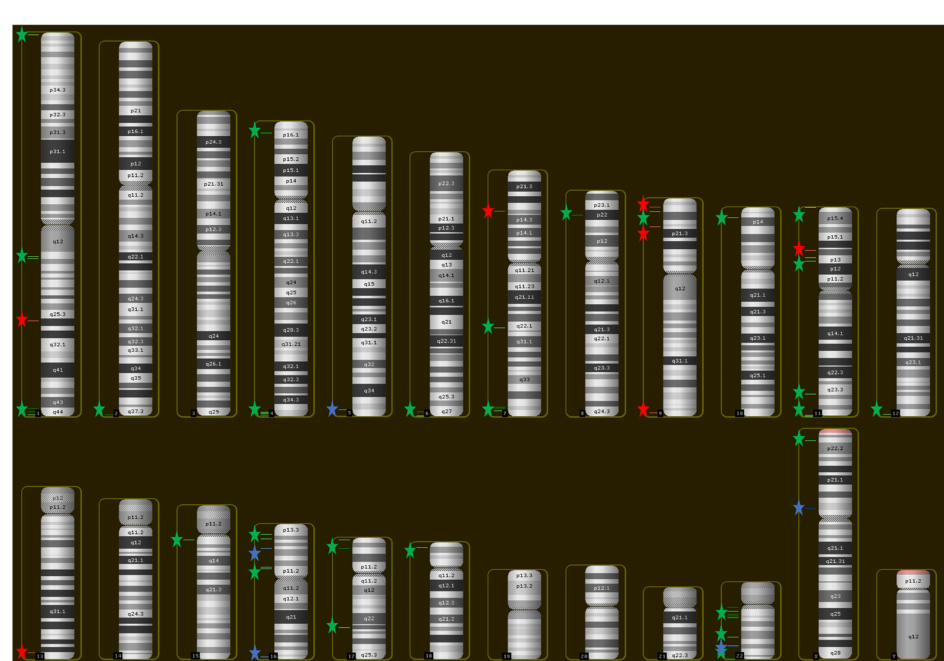
Figure 2. SRO Distribution across the Genome. Chromosomal locations for each SRO were used to construct a BED (Browser Extensible Data) file which was imported into Chromosome Analysis Suite (ChAS; Affymetrix, Inc./Thermo Fisher Scientific, Santa Clara, CA, USA) as a track. Green stars indicate SROs or clusters of SROs composed strictly of duplications, red stars indicate deletions, and blue stars indicate SROs that featured both types of CNVs.